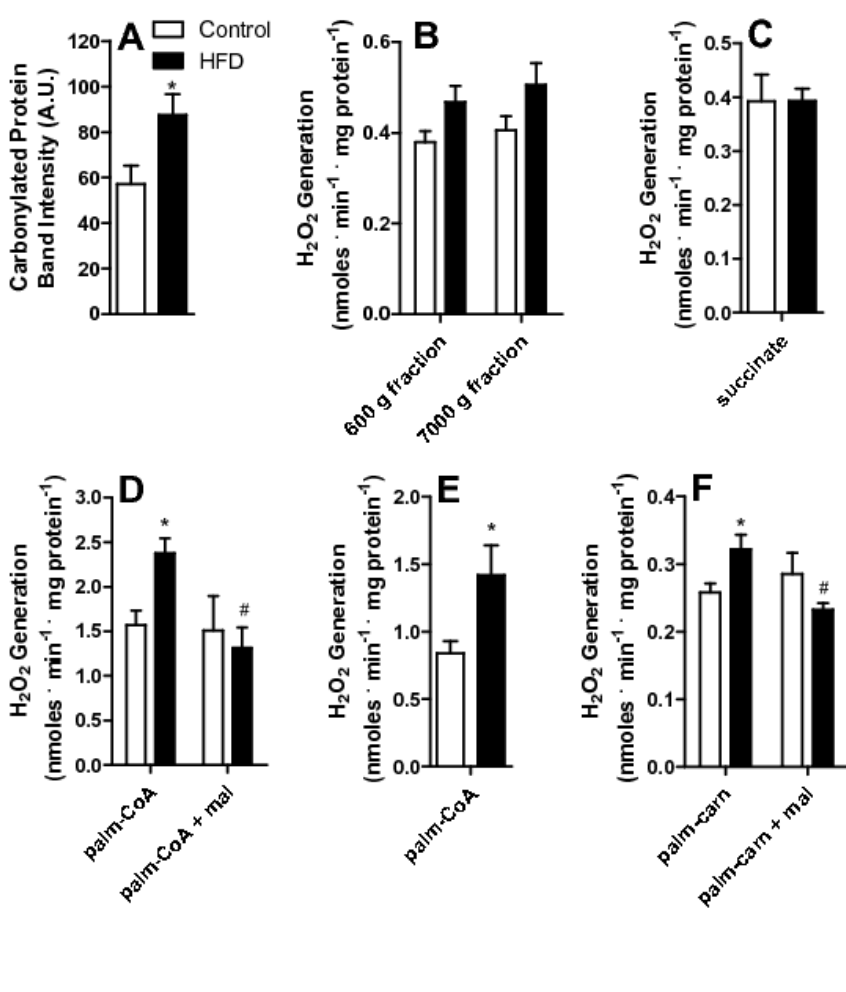
Figure 2. H O release from liver homogenate fractions. Liver homogenates from control and HFD animals were prepared as 2 2 described in Materials and Methods and incubated in buffer containing 150 mM KCl, 2 mM MgCl mM Hepes, 0.1% BSA, pH 7.4. 5 μM Amplex Red and 1 U/mL HRP were present to measure H detected as described in Materials and Methods; (B) H fractions; (C) Mitochondrial fraction incubated in the presence of 2 mM succinate; (D) Mitochondrial fraction incubated in the presence of 50 μM palmitoyl-CoA (palm-CoA) and 50 μM malonyl-CoA (mal), where indicated; (E) Percoll-purified mitochondrial fractions incubated in the presence of 50 μM palmitoyl-CoA; (F) Mitochondrial fraction incubated in the presence of 50 μM palmitoyl- carnitine (palm-carn) and 50 μM malonyl-CoA (mal); *, p < 0.05 versus control, # , p < 0.05 versus HFD in the absence of malolyl- CoA, n = 6 per group.